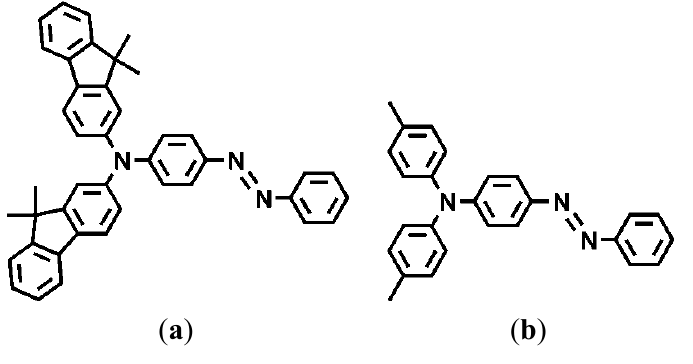
Figure 1. Chemical structures of the materials used in the present study. ( a ) BFlAB; ( b ) BMAB; ( c ) DBAB; ( d ) NO 2